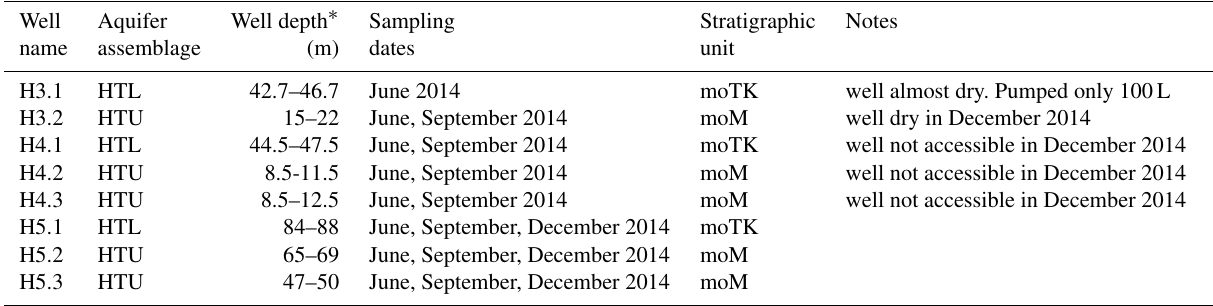
Table 2. Well depths, sampling dates and stratigraphic units of the monitoring wells studied. Well Aquifer Well depth ∗ Sampling Stratigraphic